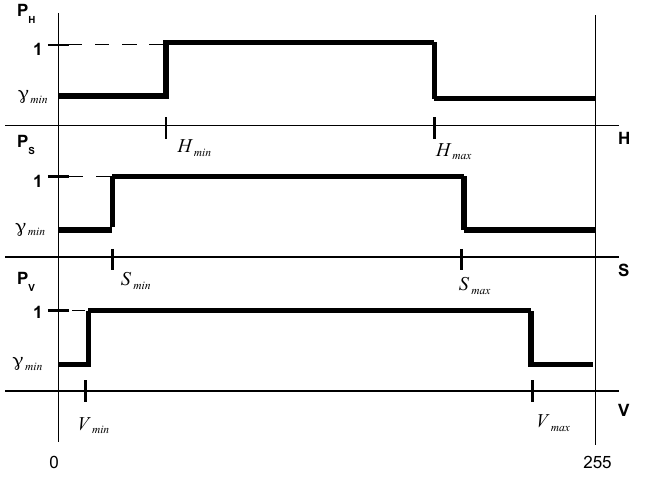
Figure 11. Reference range of the Hue, Saturation, Value (HSV)